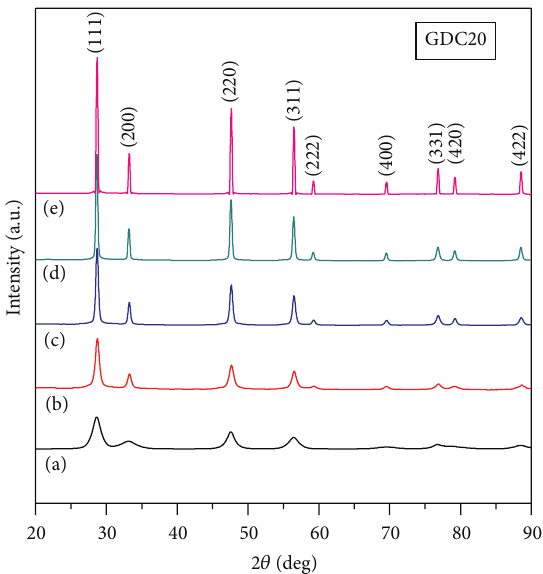
Figure 6: X-ray diffraction patterns of GDC20 nanofibers calcined at different temperature for (a) 500 ∘ C, (b) 600 ∘ C, (c) 700 ∘ C, (d) 800 ∘ C, and (f) 900 ∘ C for 8h in